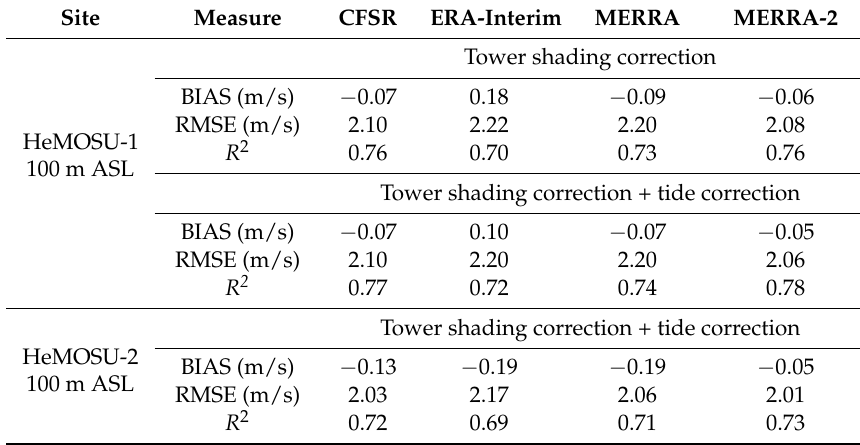
Table 5. Comparison between the HeMOSU-1 and HeMOSU-2 measurements and reanalysis data.